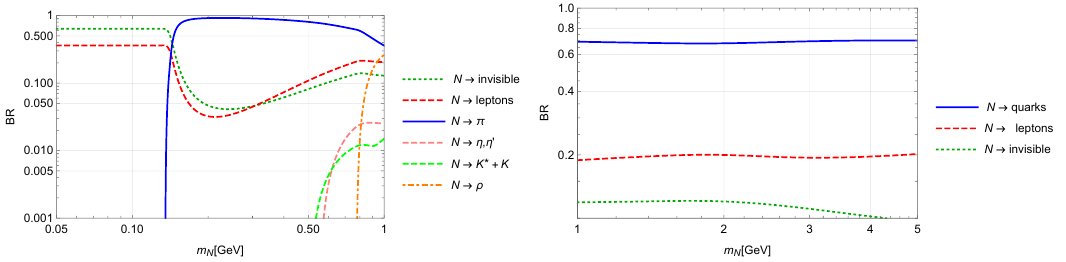
Figure 4 . Branching ratios in the minimal scenario for U e 4 = 1 and U (cid:22) 4 = U (cid:28) 4 = 0. Left: m N < 1 GeV with decays to individual mesons. Right: m N > 1 GeV and the decays to quarks correspond to the total hadronic branching